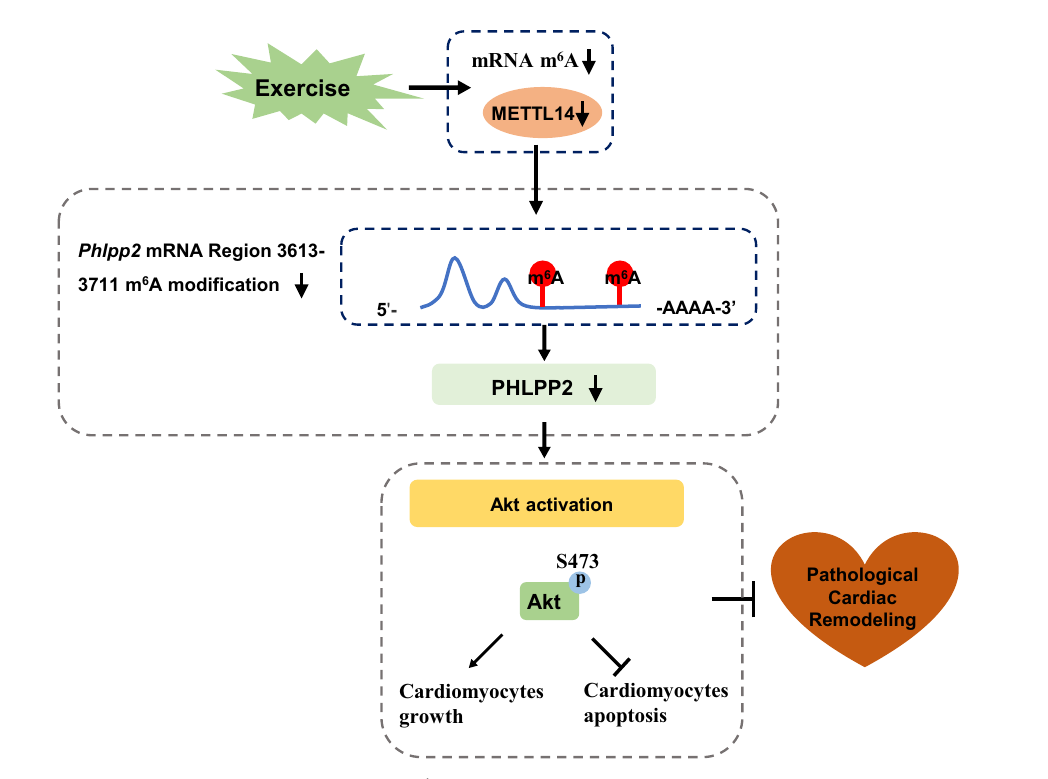
Fig. 9 | Proposed working model by which downregulation of RNA m 6 A methyltransferase METTL14 contributes to exercise-induced cardiac hyper- trophy and protects against myocardial ischemia-reperfusion injury. Endur- ance exercise leads to a reduced mRNA m 6 A methylation level. Cardiac-speci fi c knockdown METTL14 reduces global RNA m 6 A modi fi cation, thereby attenuating